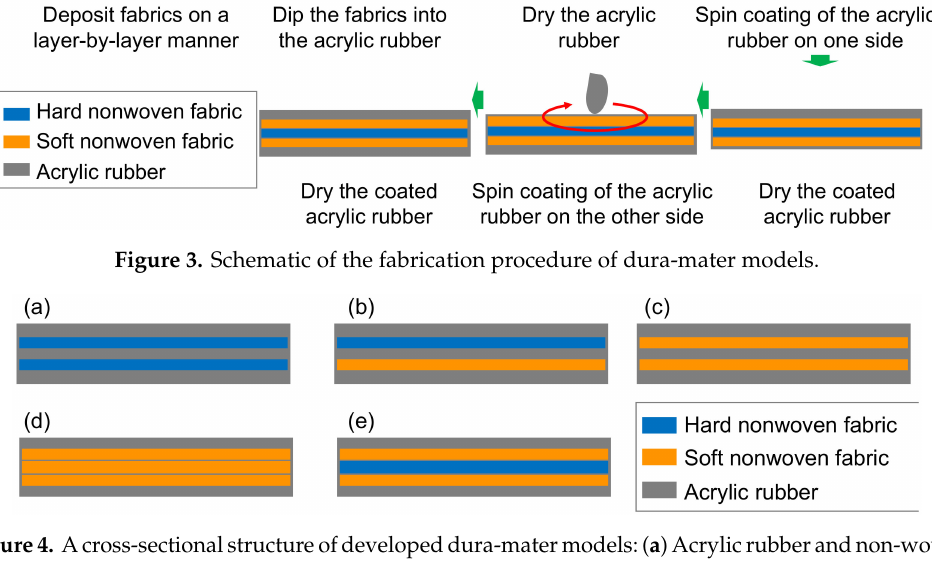
Figure 4. A cross-sectional structure of developed dura-mater models: ( a ) Acrylic rubber and non-woven fabric (hard and hard); ( b ) Acrylic rubber and non-woven fabric (hard and soft); ( c ) Acrylic rubber and non-woven fabric (soft and soft); ( d ) Acrylic rubber and non-woven fabric (soft and soft and soft); ( e ) Acrylic rubber and non-woven fabric (soft and hard and